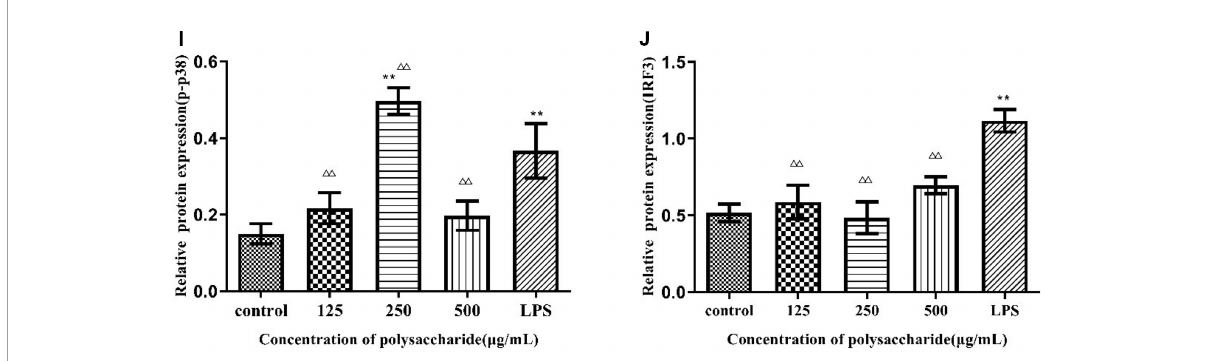
FIGURE9 Effects of Sparassis latifolia neutral polysaccharides SLNP western blot results on protein expression. (A) , TLR4 (B) , TRAF6 (C) , JNK (D) , p-JNK (E) , ERK (F) , p-ERK (G) , p38 (H) , p-p38 (I) , and IRF3 (J) in RAW264.7 macrophage. Compared with blank control group, * p < 0.05, ** p < 0.01; Compared with LPS control group, (cid:49) p < 0.05 , (cid:49)(cid:49) p < 0.01.